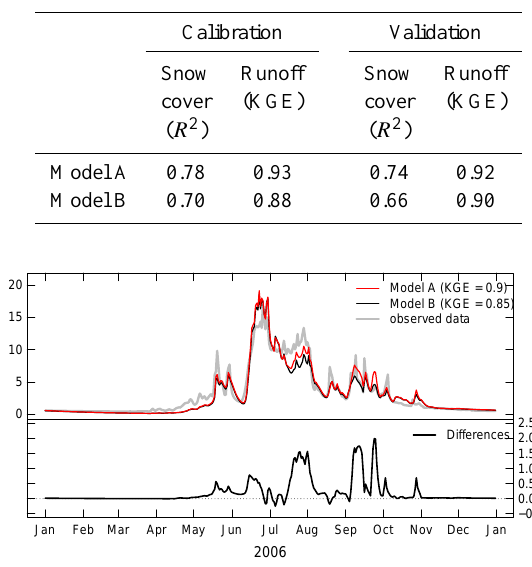
Table 2. Comparison of performances of models A and B with re- spect to snow cover and runoff. For snow cover, the coefficient of determination ( R 2 ) was used, whereas the Kling–Gupta efficiency (KGE; Gupta et al., 2009) was used for runoff.